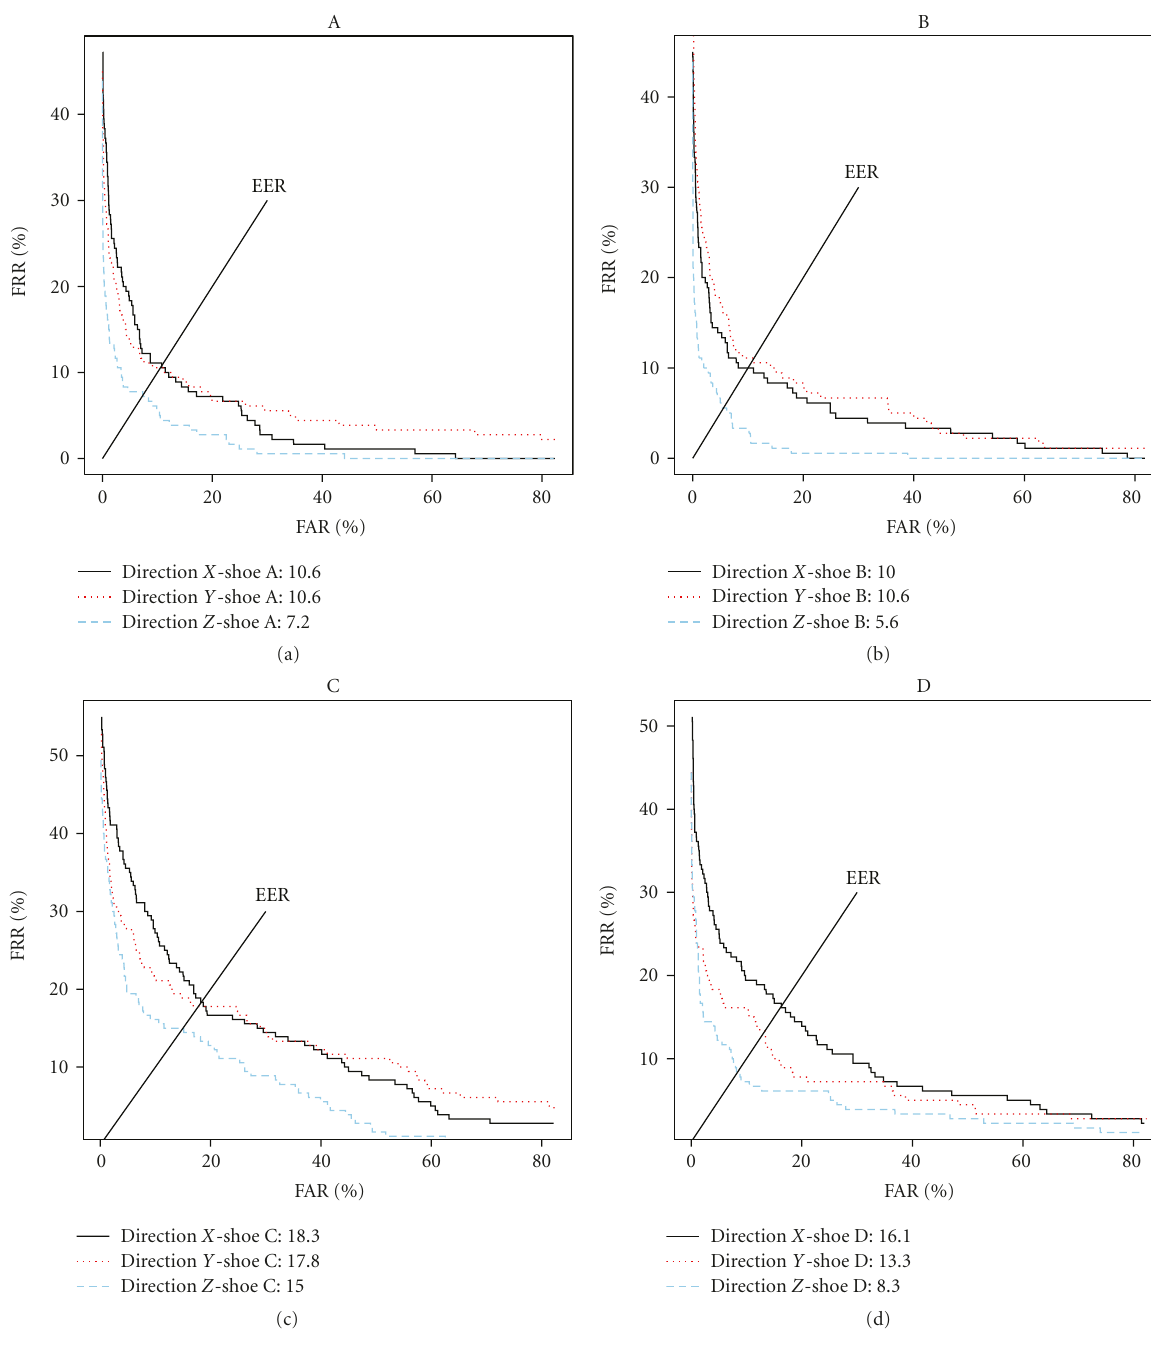
Figure 10: Authentication with respect to directions for shoe types A, B, C, and